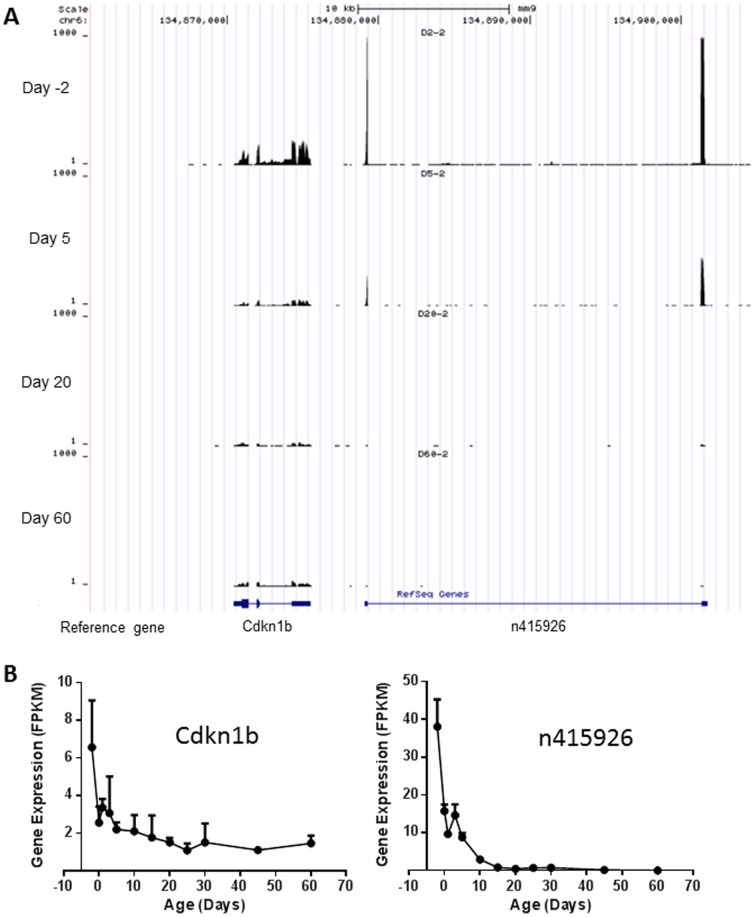
Developmental expression of lncRNA n415926 (identified by Noncode v3.0) and its neighbor protein coding gene Cdkn1b.(A) Sequence read distribution at day −2, 5, 20, and 60 viewed by the UCSC genome browser. (B) Gene expression (represented by FPKM) across the 12 selected ages.